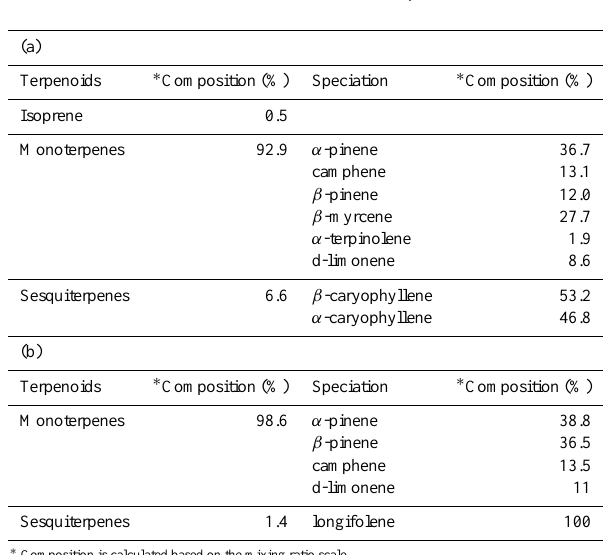
Table 2. Terpenoid speciation analysis results from GC-MS